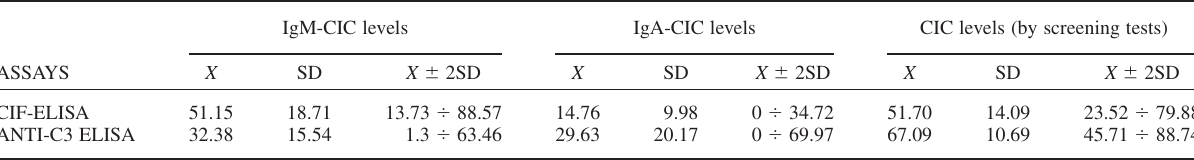
TABLE I Meanvalue ( X ), standard deviation (SD) and range ( X ^ 2SD) of IgM-CIC and IgA-CIC detected for control group of healthy blood samples by CIF-ELISA, ANTI-C3 ELISA, and for total CIC levels by screening CIF-ELISA, ANTI-C3 ELISA